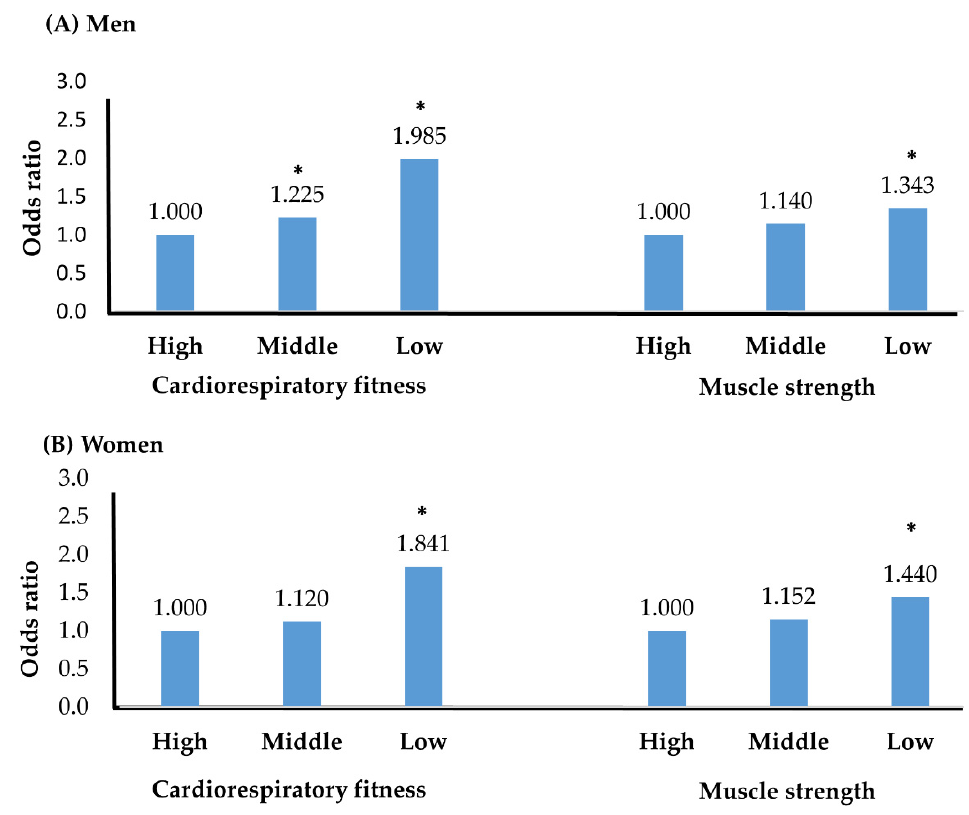
Figure 2. Prevalence of colorectal polyps according to fitness level. ( A ) men’s odds ratio; ( B ) women’s odds ratio; * p < 0.05; adjusted variables included age, cardiorespiratory fitness, muscle strength, smoking, income, physical activity for men, and age, cardiorespiratory fitness, muscle strength, and waist circumference for women .